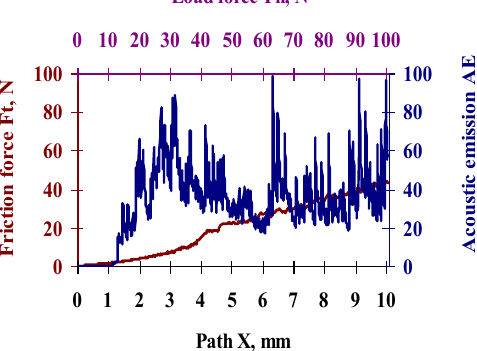
Figure 10. Friction force ( F t ) and acoustic emission (AE) as a function of the load ( F n ) for AlCrN coating.